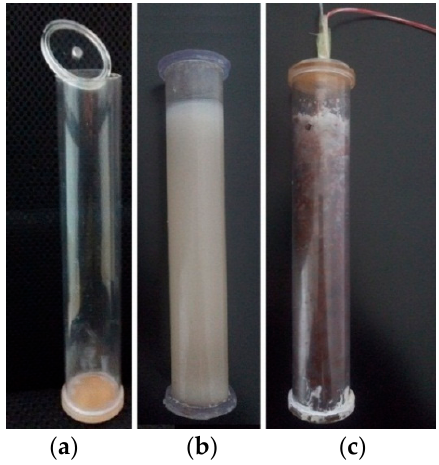
Figure 3. The produced container and PCM cylinder modules: ( a ) PET plastic container; ( b ) module without float stones; ( c ) module with float stones.